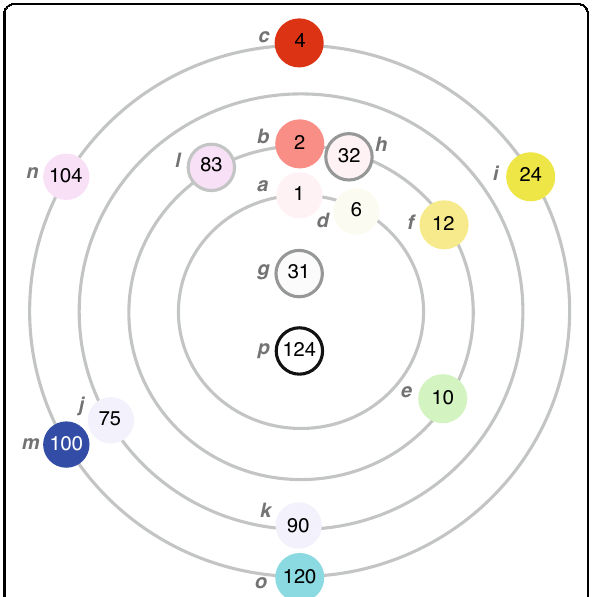
Fig. 7 Visualization of the relationship of 16 people ’ s features. each has 5 category values. All these 16 individuals can be allocated on a 4-ring hue